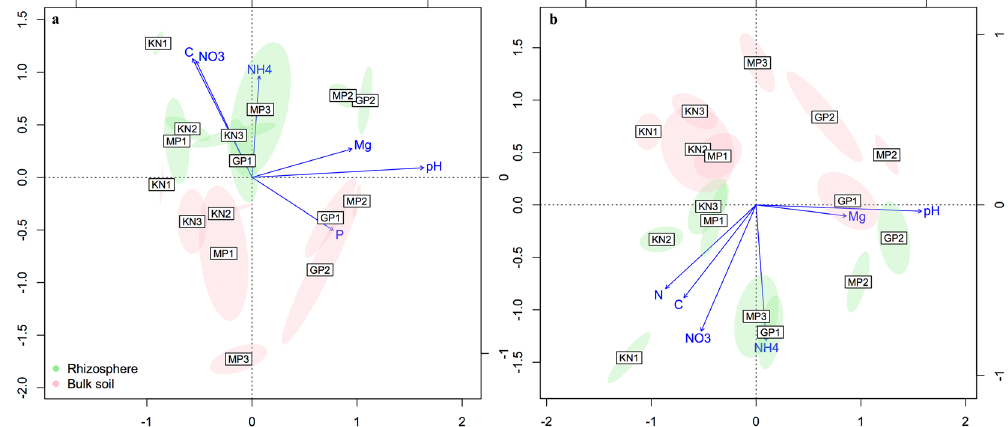
Figure 2. Distance-based redundancy analysis (db-RDA) biplot of ( a ) bacterial and ( b ) fungal communities and soil chemistry parameters. Only the environmental variables that significantly (P < 0.05) explained variability in microbial community structure are shown (arrows). The direction of the arrows indicates the direction of maximum change of that variable, whereas the length of the arrow is proportional to the rate of change. Instead of plotting each sampling point, ellipses are shown that represent the standard error around location centroids.